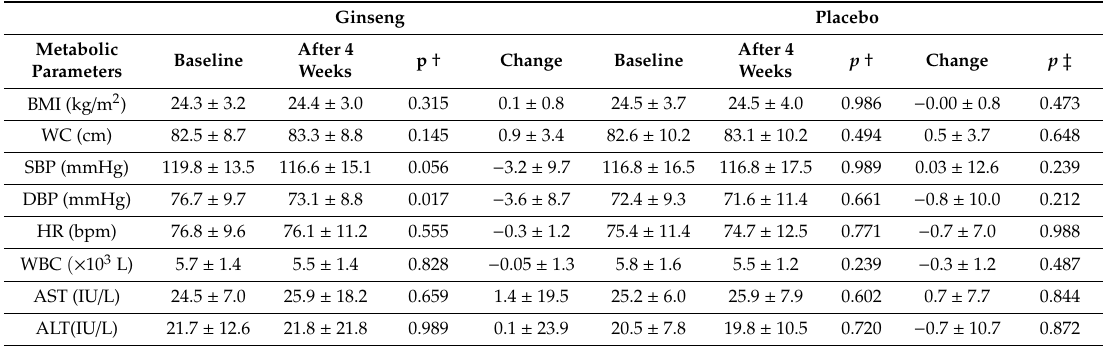
Table 2. Changes in metabolic parameters and cholesterol metabolites in the ginseng and placebo groups before and after the 4-week